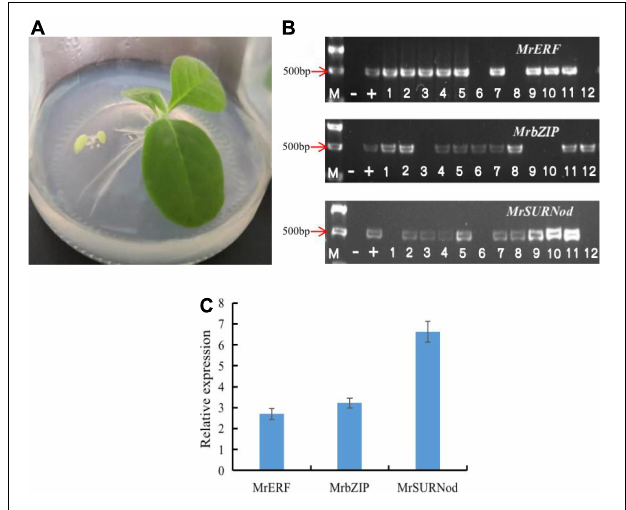
FIGURE 3 | Transgenic plant identification. (A) Antibiotic selection; (B) identification of transgenic plants by PCR [“M”, Marker (DL2000); “ – ”, negative control; “ + ”, positive control, the rest were transgenic plants]; (C) qRT-PCR analysis of MrERF , MrbZIP , and MrSURNod in transgenic tobaccos.